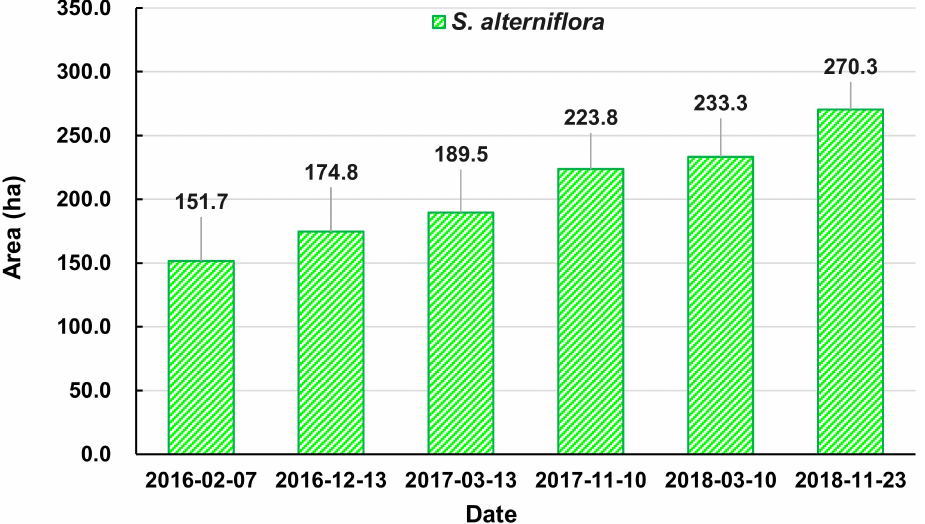
Figure 7. Coverage area of S. alterniflora from the beginning of the growing season in 2016 to the beginning of the dormant season in 2018. Table 5. S. alterniflora change during growing season and dormant season from 2016–2018. Stage Change of Area (ha) Change Rate (%) Growing seasons 2016 / 02 / 07-2016 / 12 /